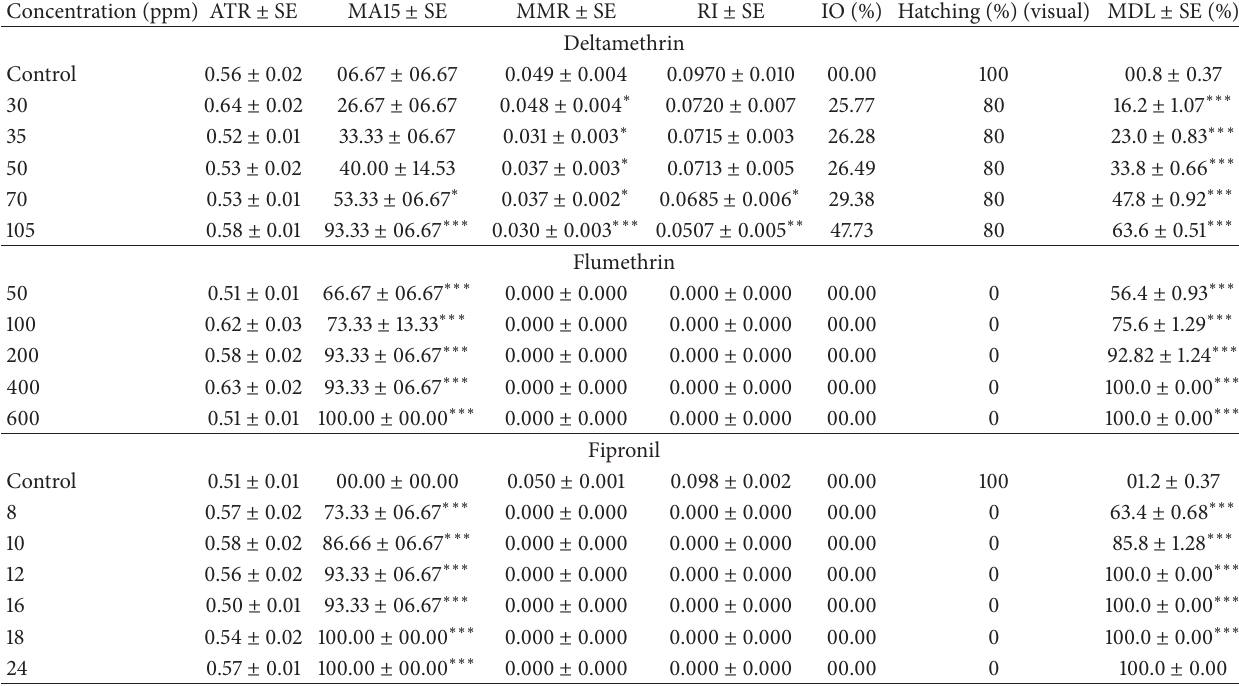
Table 1: Dose dependent response of Adult Immersion Test (AIT) and Larval Packet Test (LPT) to various commercial preparations against R. (B.) microplus .